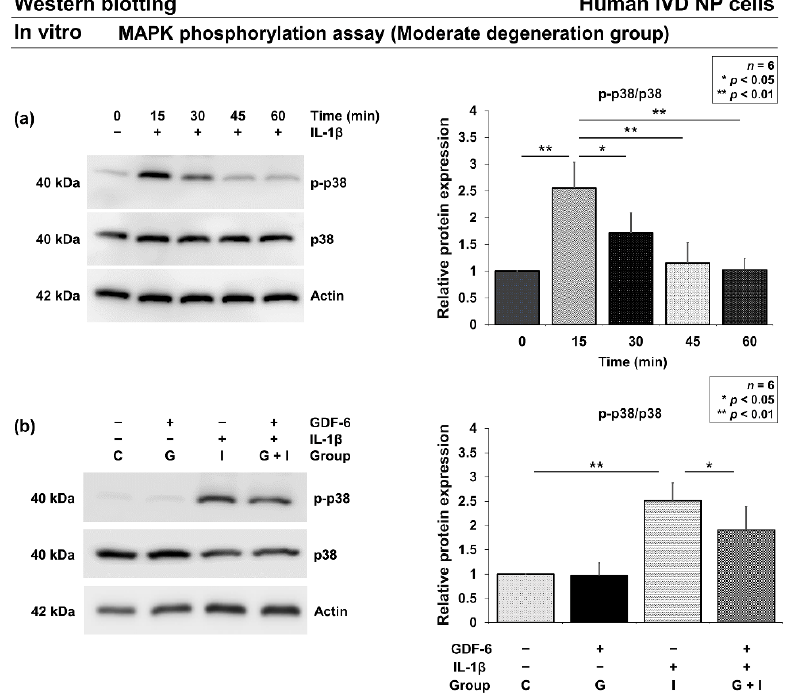
Figure 4. Effects of growth differentiation factor-6 (GDF-6) on p38 phosphorylation under pro-inflammatory condition. ( a ) Time-course change in p-p38 protein levels relative to p38. We